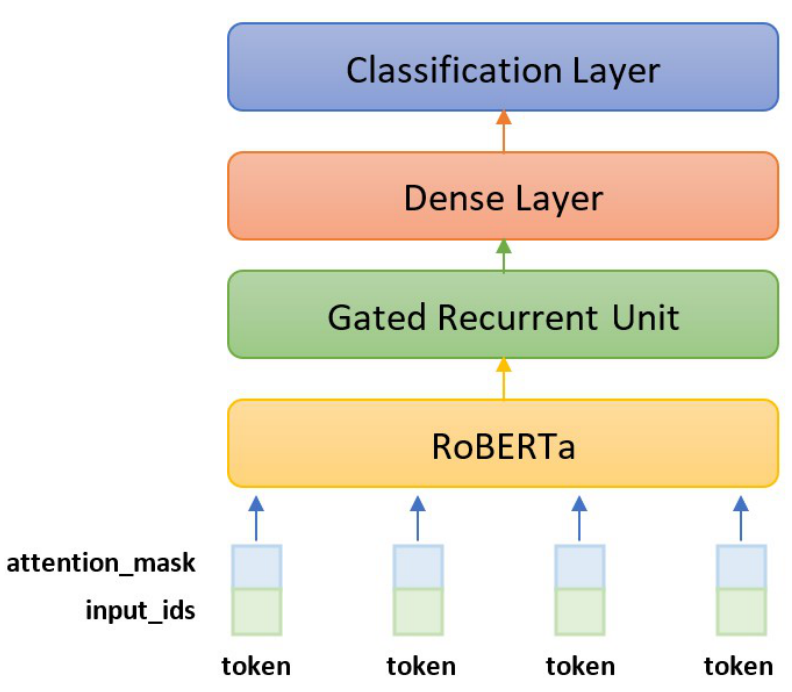
Figure 2. The architecture of the proposed RoBERTa-GRU